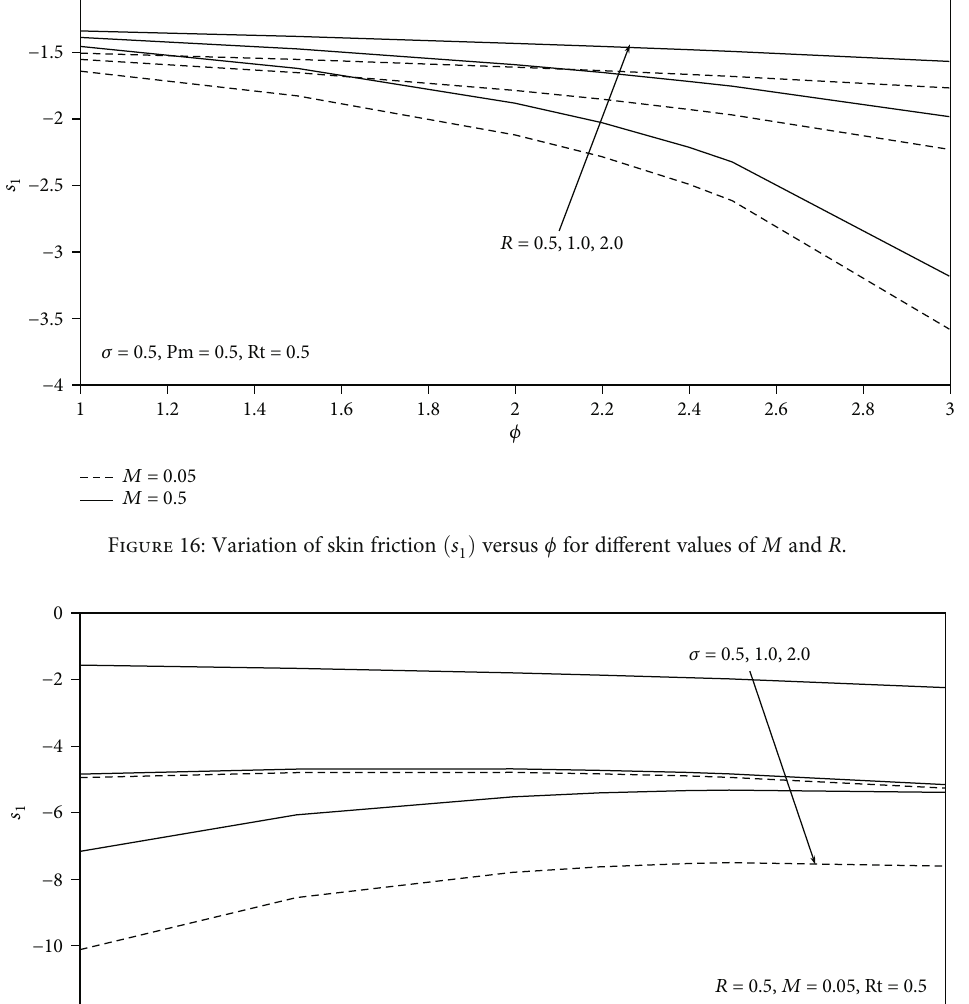
Figure 17: Variation of skin ð s